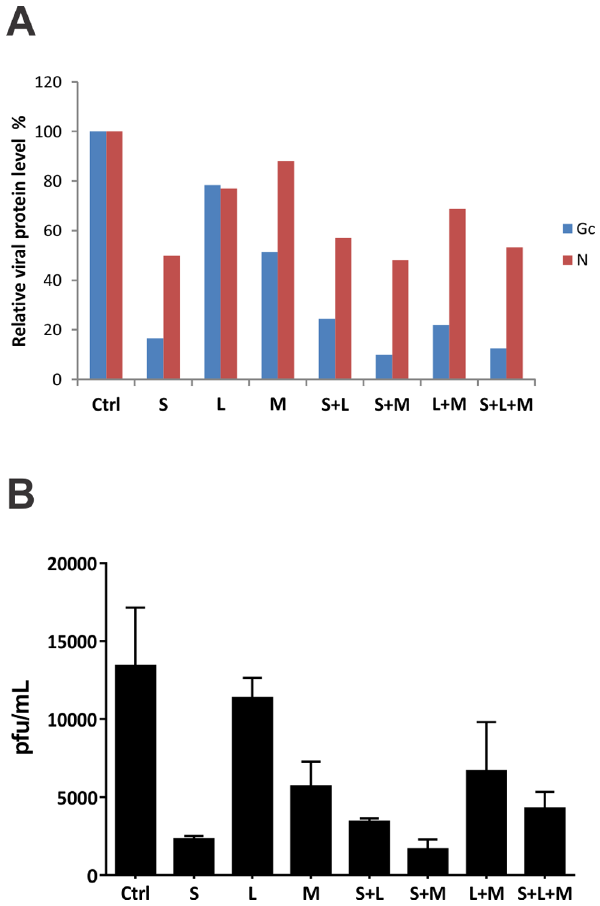
Figure 2. siRNA inhibits production of infectious ANDV. (A) Viral protein levels determined by Western blot analysis. Vero-E6 cells were transfected with 33 nM of each siRNA pool (S, L, or M) alone or in combination (S + L, S + M, L + M, or S + L + M) for 6 h. The total concentration of each transfection was brought up to 100 nM with scrambled siRNA. Cells treated with only scrambled siRNA were used as control. The cells were then infected with ANDV at MOI =0.5. ANDV Gc and N protein levels were determined by densitometry. (B) ANDV production and release were determined by immunofocus assays. All experiments were performed in quadruplicate.